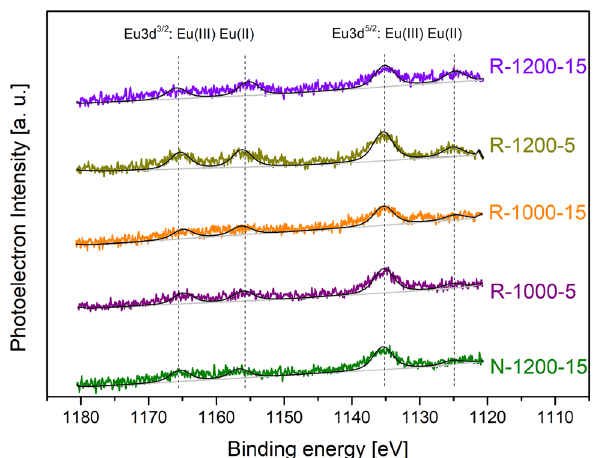
Figure 7. The Eu3d high-resolution XPS spectra of investigated samples. Signals from samples are marked with respected colors and the fits are represented by gray or black